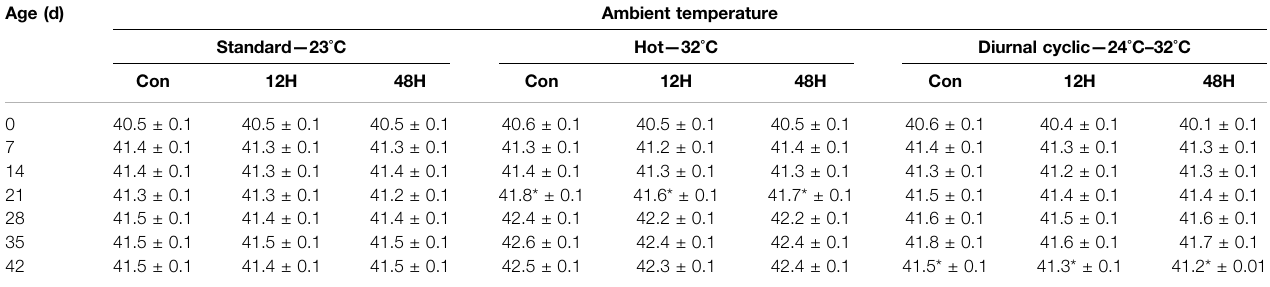
TABLE 3 | Body temperature ( ° C) of broilers exposed to different hypoxia regimes during embryonic development and then raised under different environmental ambient temperatures (analyzed within each ambient temperature). Age